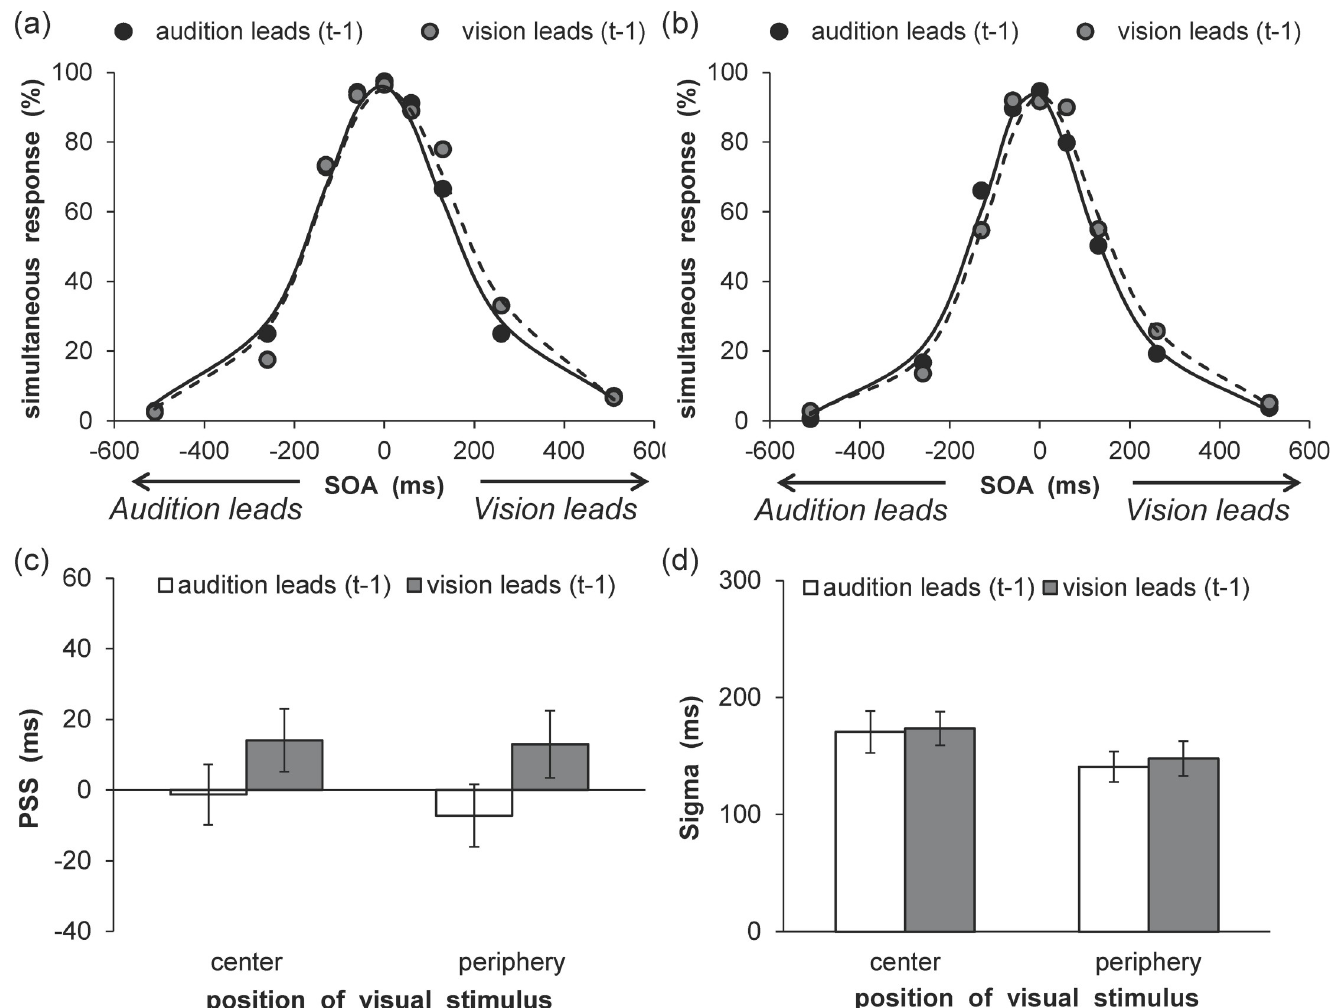
Fig 5. Results of rapid recalibration analyses in Experiment 2. Mean percentage of simultaneous responses in the (a) central and (b) peripheral visual fields. The average fitting functions are plotted for preceding trials of audition leads and vision leads data. (c) Mean estimated point of subjective simultaneity. (d) Mean estimated sigma. Error bars represent standard errors of the mean ( n =